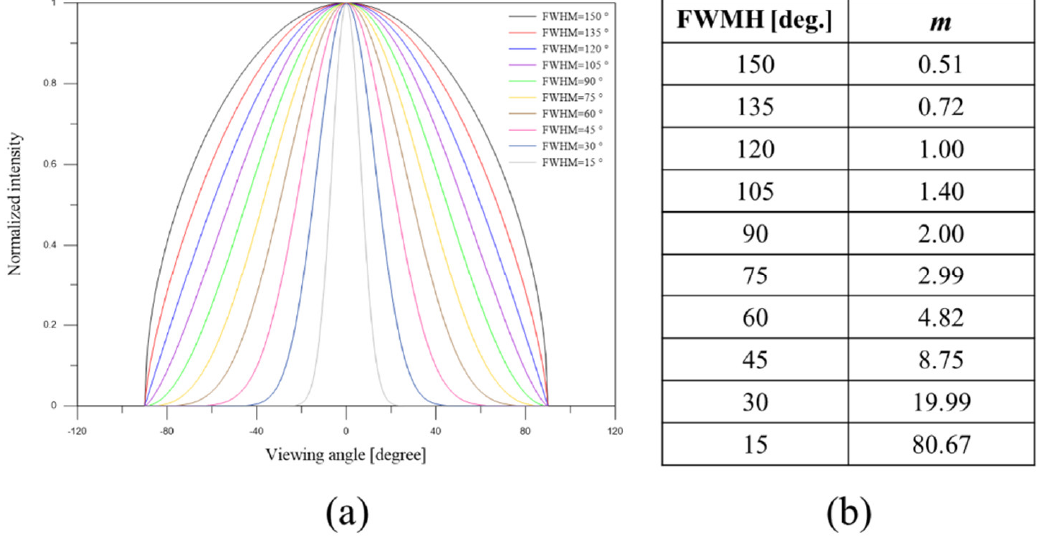
Figure 3. ( a ) XPE and ( b ) total internal reflection (TIR) lens structures.